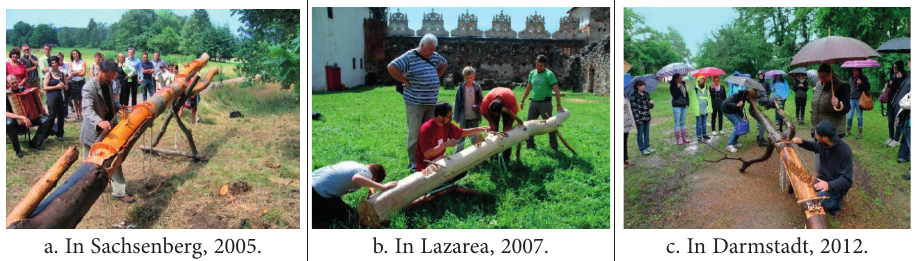
a. In Sachsenberg,